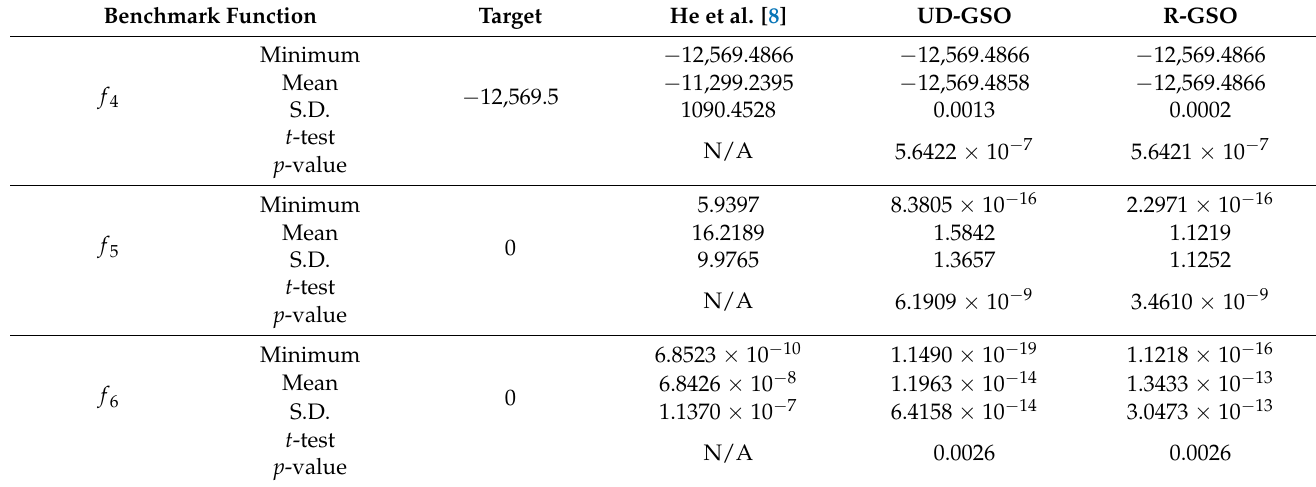
Table 13. Results comparison among GSO [8], UD-GSO, and R-GSO in multimodal functions. Benchmark Function